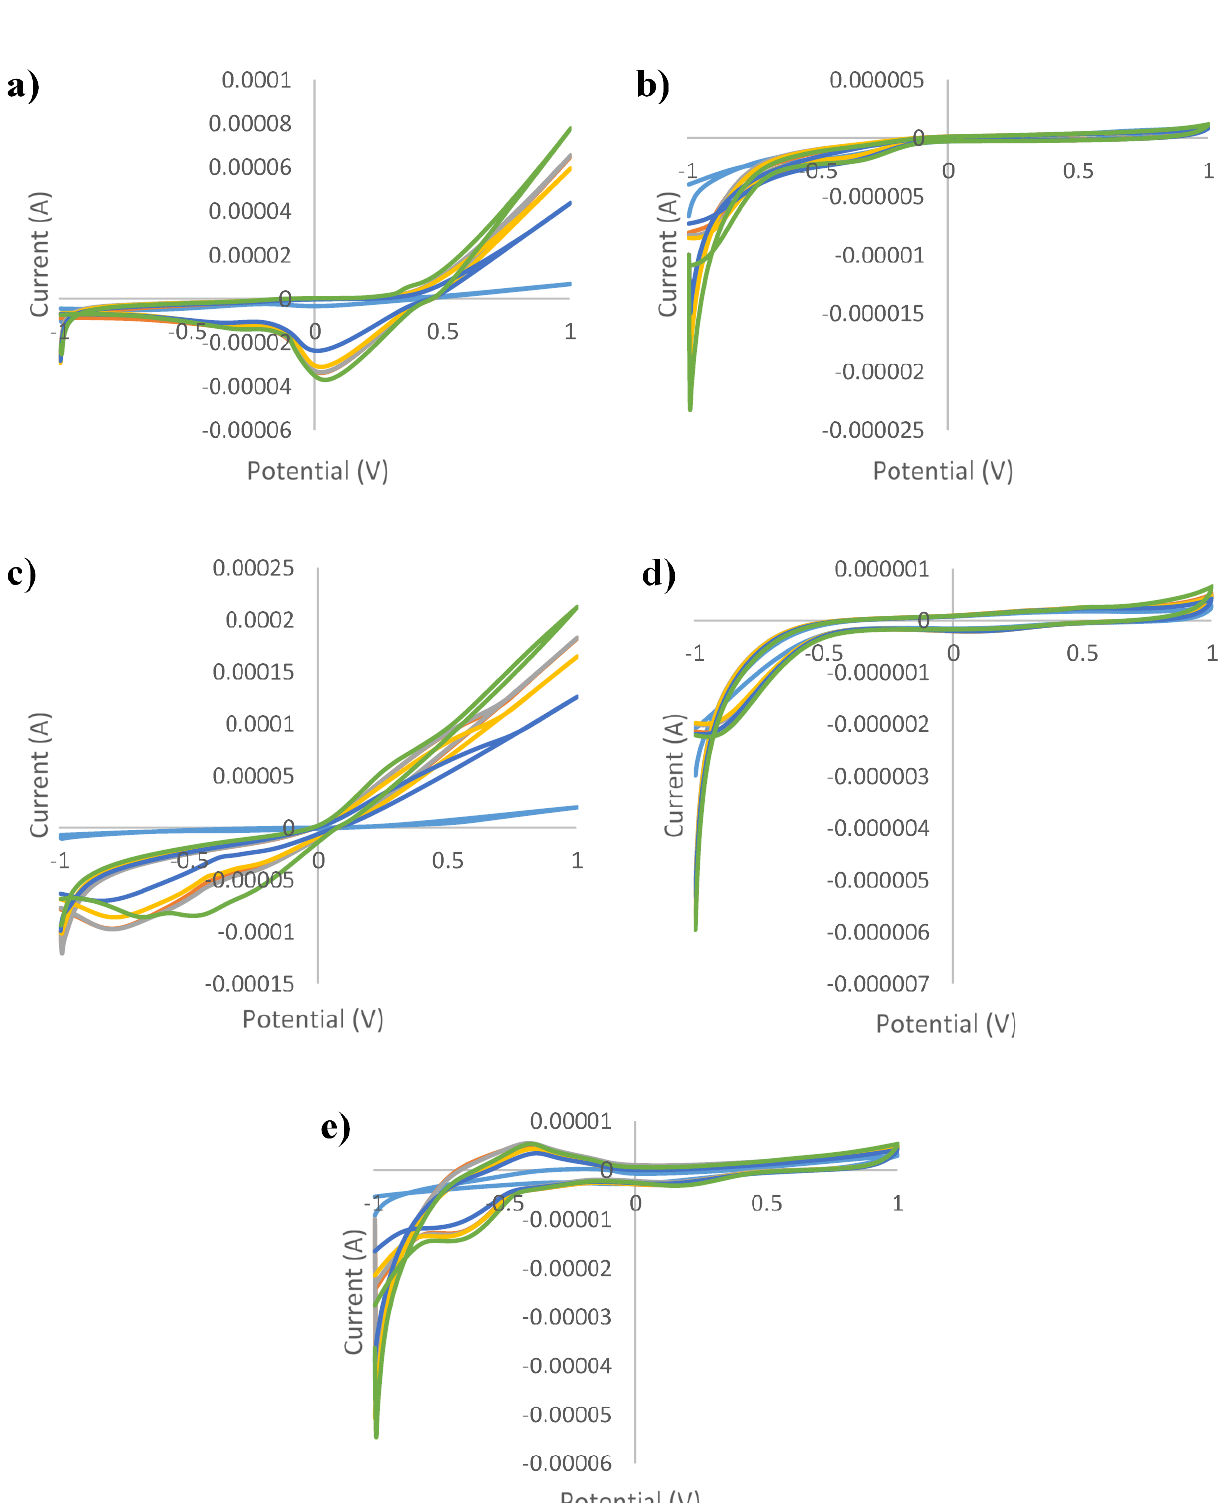
Figure 4. Cyclic voltammograms of authentic and adulterated (with corn syrup) tilia honey solutions for: ( a ) silver electrode; ( b ) gold electrode; ( c ) copper electrode; ( d ) glass electrode; ( e ) platinum electrode and green line—authentic honey; light blue line—agave syrup; red line—honey adulteration 5%; gray line—honey adulteration 10%; orange line—honey adulteration 20%; dark blue—honey adulteration 50%.